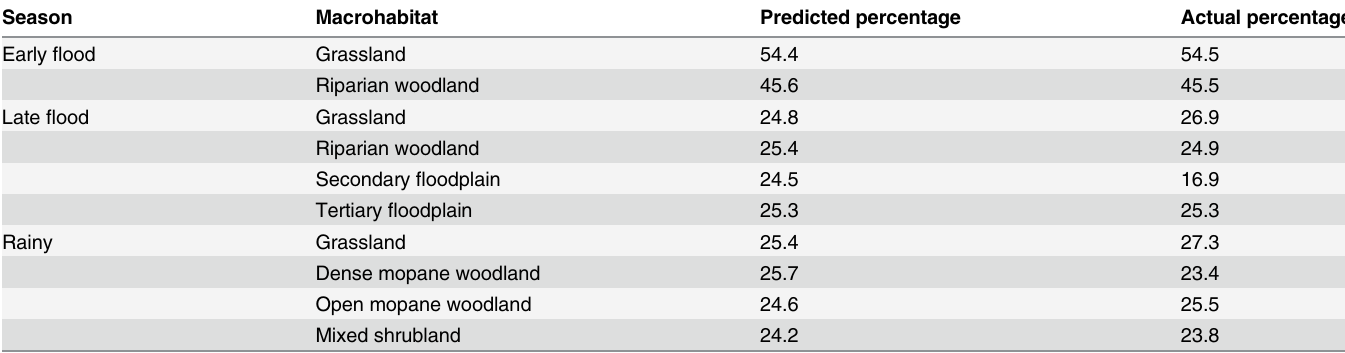
Table 6. Percentages of samples assigned to seasonally-preferred macrohabitats from actual data and from multilevel model predictions. Season